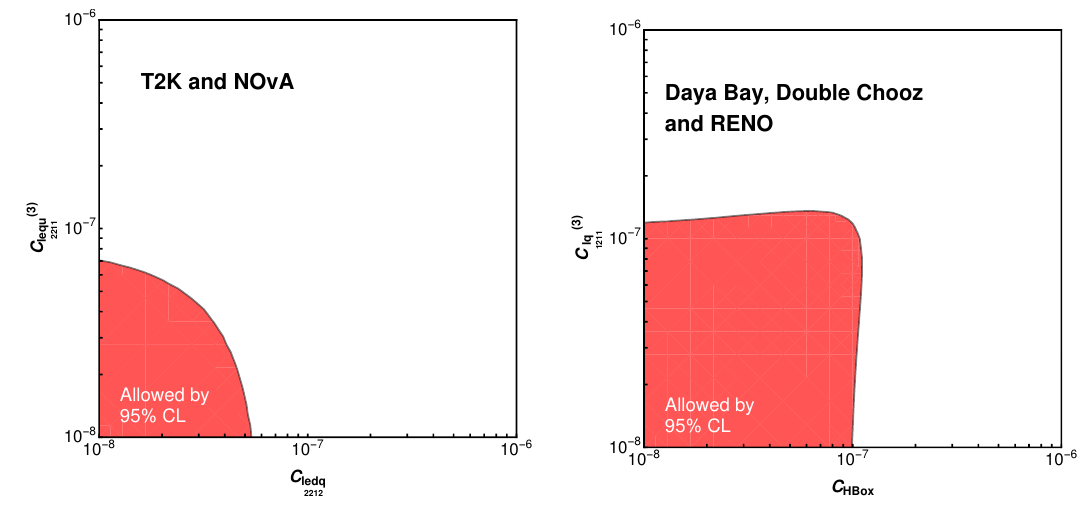
Figure 12 . Left panel: upper constraints on the Wilson coefficients corresponding to the opera- tors (¯ ‘ 2 e 2 ) ε jk (¯ q 1 u 1 ) and (¯ ‘ 2 e 2 )( ¯ d 1 q 1 ) with Λ = 1 TeV. The constraints are obtained for the LBL experiments T2K and NO ν A at 95% CL significance. Right panel: same as the left panel but with the application of the reactor experiments Daya Bay, Double Chooz and RENO with operators ( φ † φ ) (cid:3) ( φ † φ ) and (¯ ‘ j σ µν e 1 ) ε jk (¯ q k σ µν u 1 ) 1 1